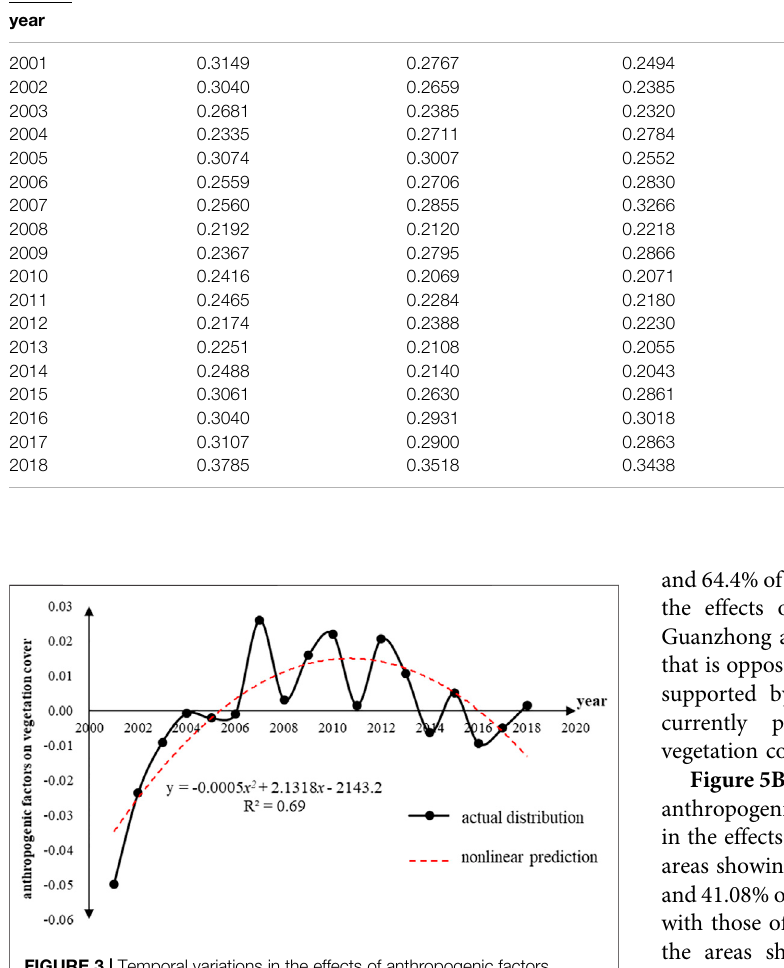
FIGURE 3 | Temporal variations in the effects of anthropogenic factors on vegetation cover in Guanzhong, Central China.